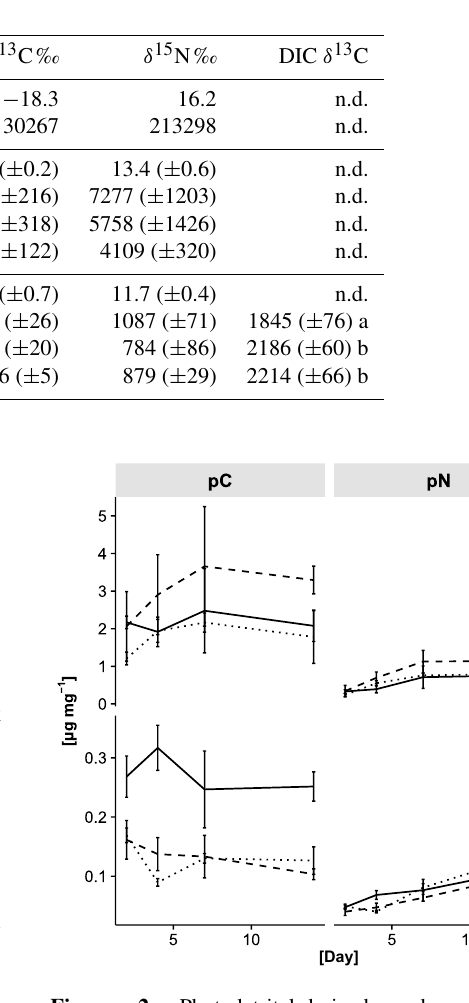
Table 1. Delta values for carbon and nitrogen isotopes. Natural δ 13 C and δ 13 N values of unlabelled background samples (BG), isotopically enriched samples of food ( D. tertiolecta ) and foraminifera and DIC- δ 13 C within water samples on the second day of the incubation period (standard deviation in parenthesis; letters denote Tukey Grouping of significant differences in DIC- δ 13 C between temperatures; n.d. is no data).